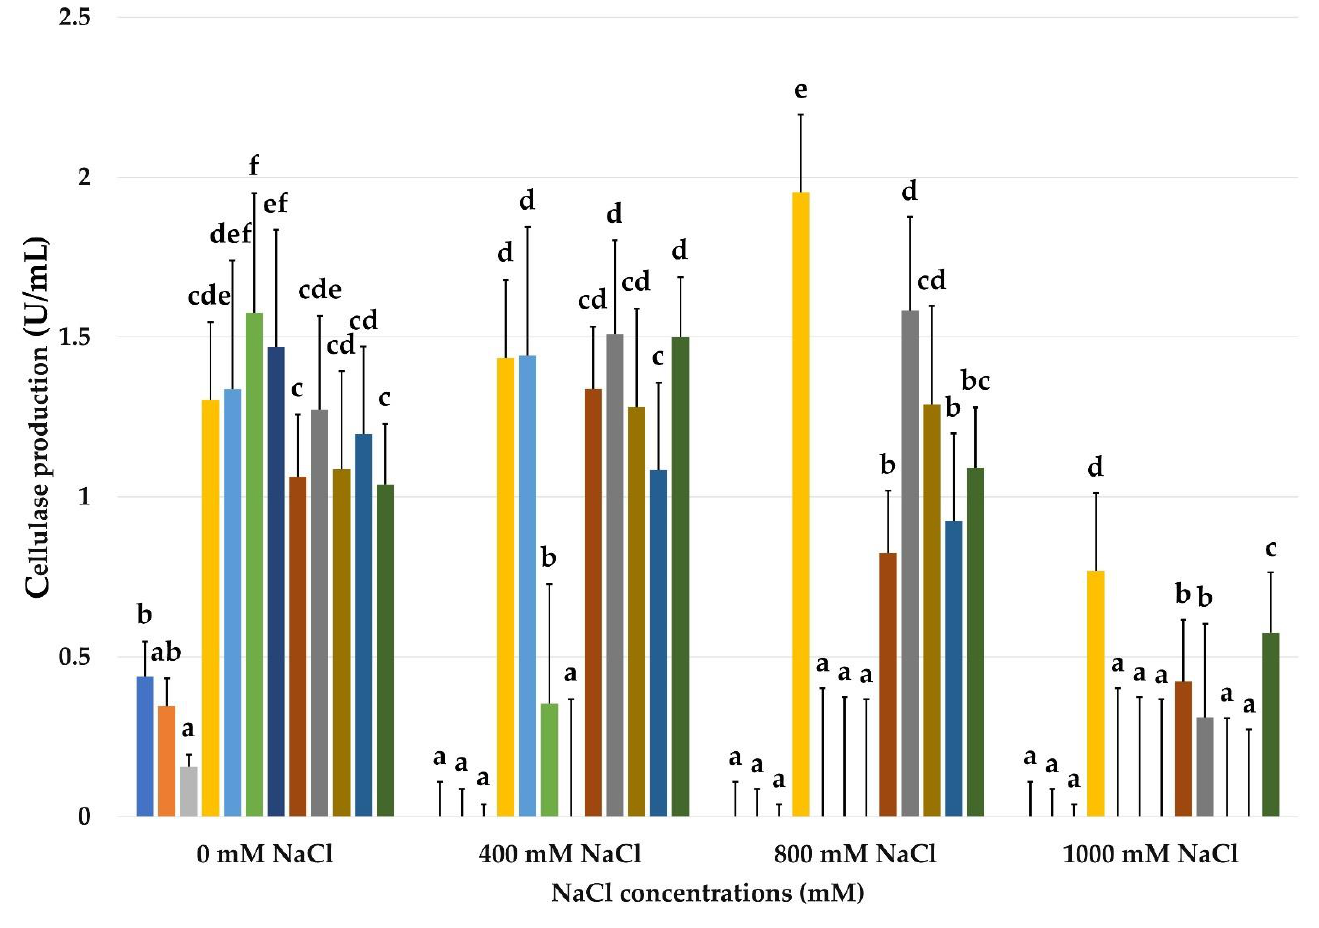
Figure 6. Effect of NaCl concentration on the production of CMCase in CMC broth (1%) of the 12 isolates tested. The results are expressed as the mean-standard error of the values of the enzymatic units in duplicate. The effects of saline concentration of production corresponding to each treatment and not sharing the same letters are significantly different according to Tukey ’ s post hoc HSD test.